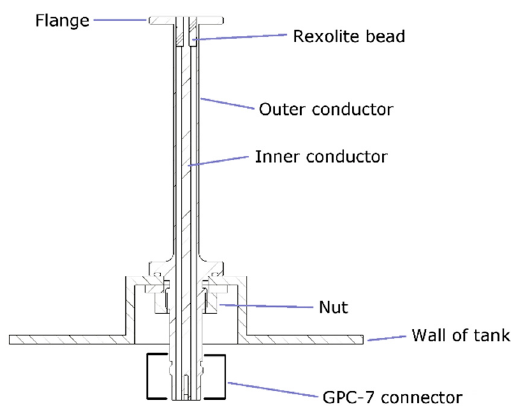
Figure 2. Design of the 7-mm open-ended coaxial probes that are used for monitoring a liquid in a sealed tank. A calibration scheme that takes account of the inaccessibility of the flange is required.